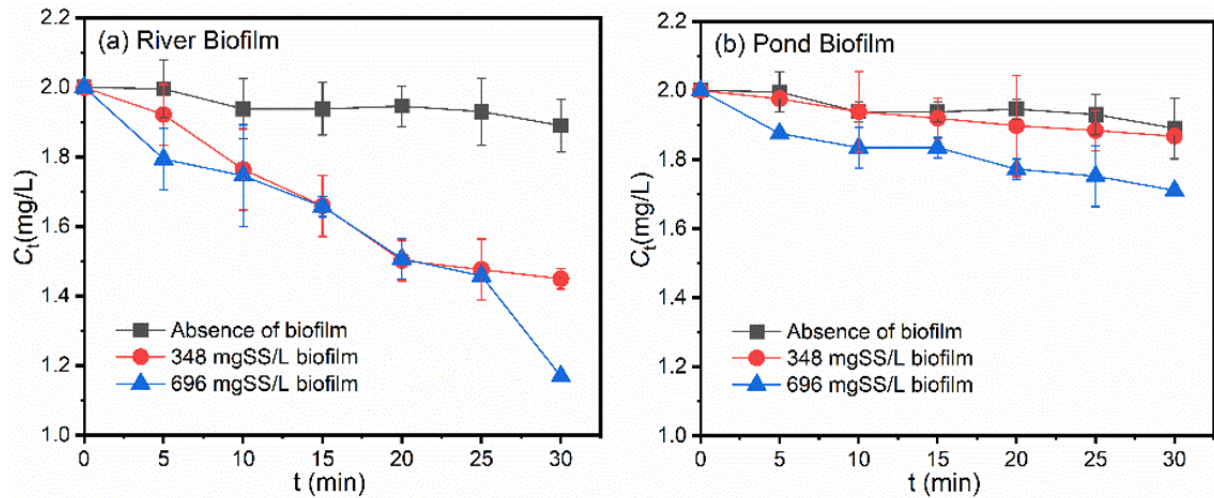
Figure 3. Impacts of ( a ) River biofilm and ( b ) Pond biofilm and concentrations on photodegradation of OM at a concentration of 2 mg/L in aqueous solutions.